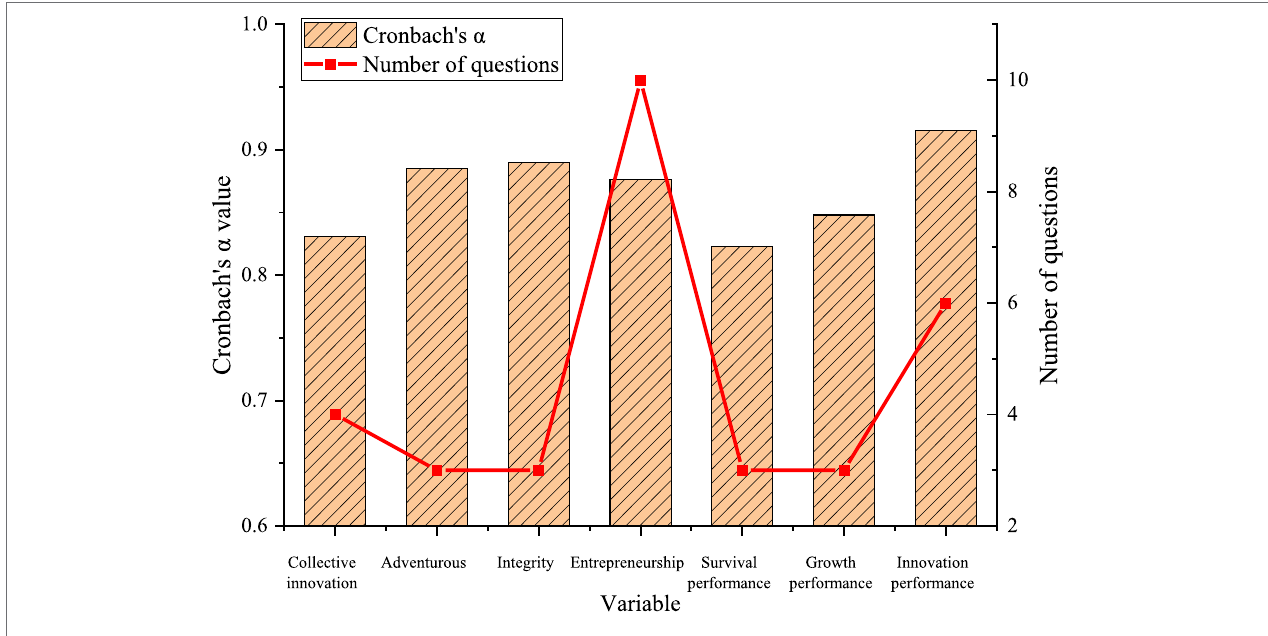
FIGURE 8 | Test results of reliability of variables and